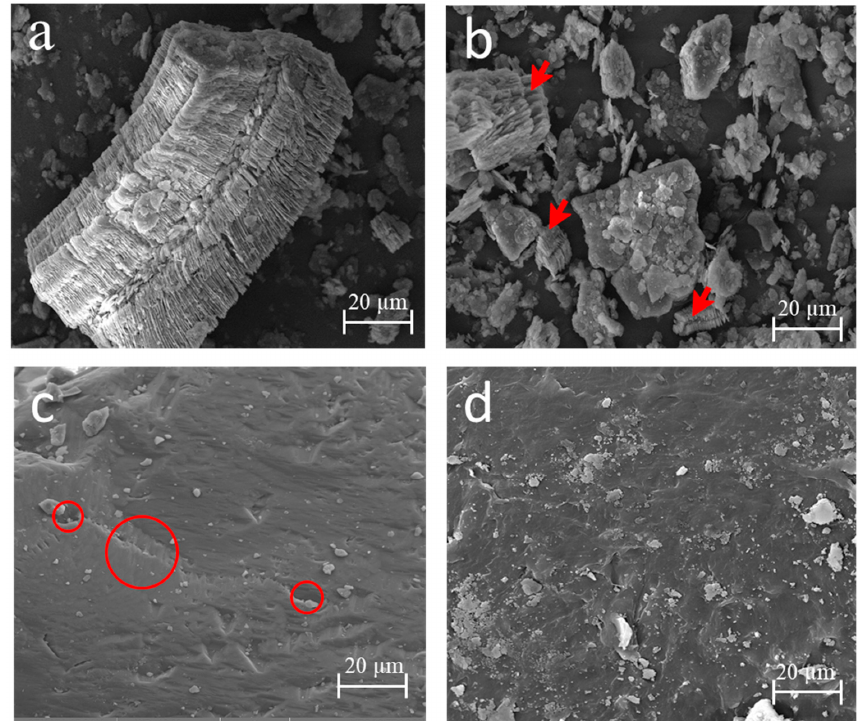
Figure 3. Micrograph image of the raw materials: kaolinite ( a ), metakaolinite with kaolinite destruction indicated by red arrows ( b ), sand with its porosity indicated by red circles ( c ), and plastic waste ( d ).